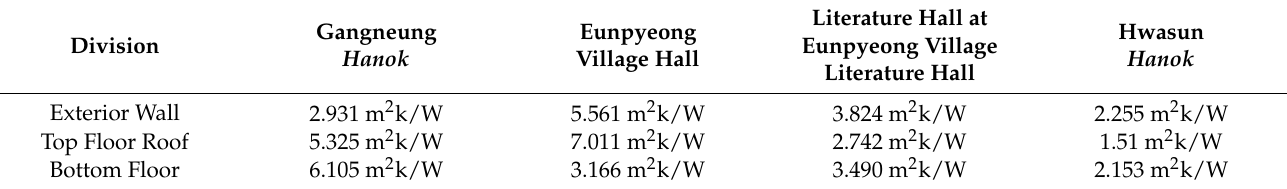
Table 7. Heat resistance of each part.